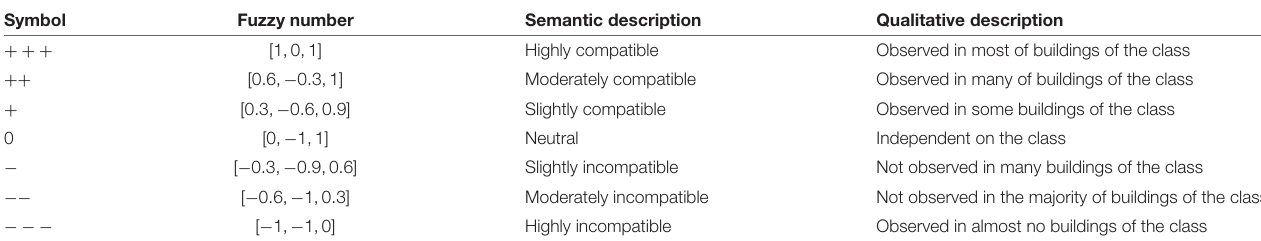
TABLE 1 | Qualitative compatibility levels to be used to assign a fuzzy score.